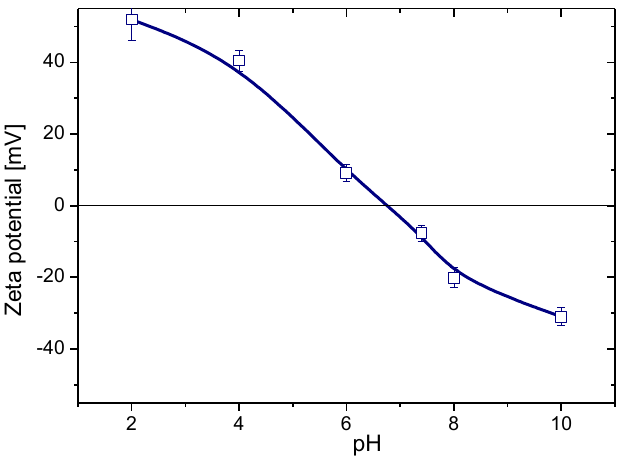
Figure 3. Zeta potential of MagP ® – OH versus pH in 5 mM KNO 3 .